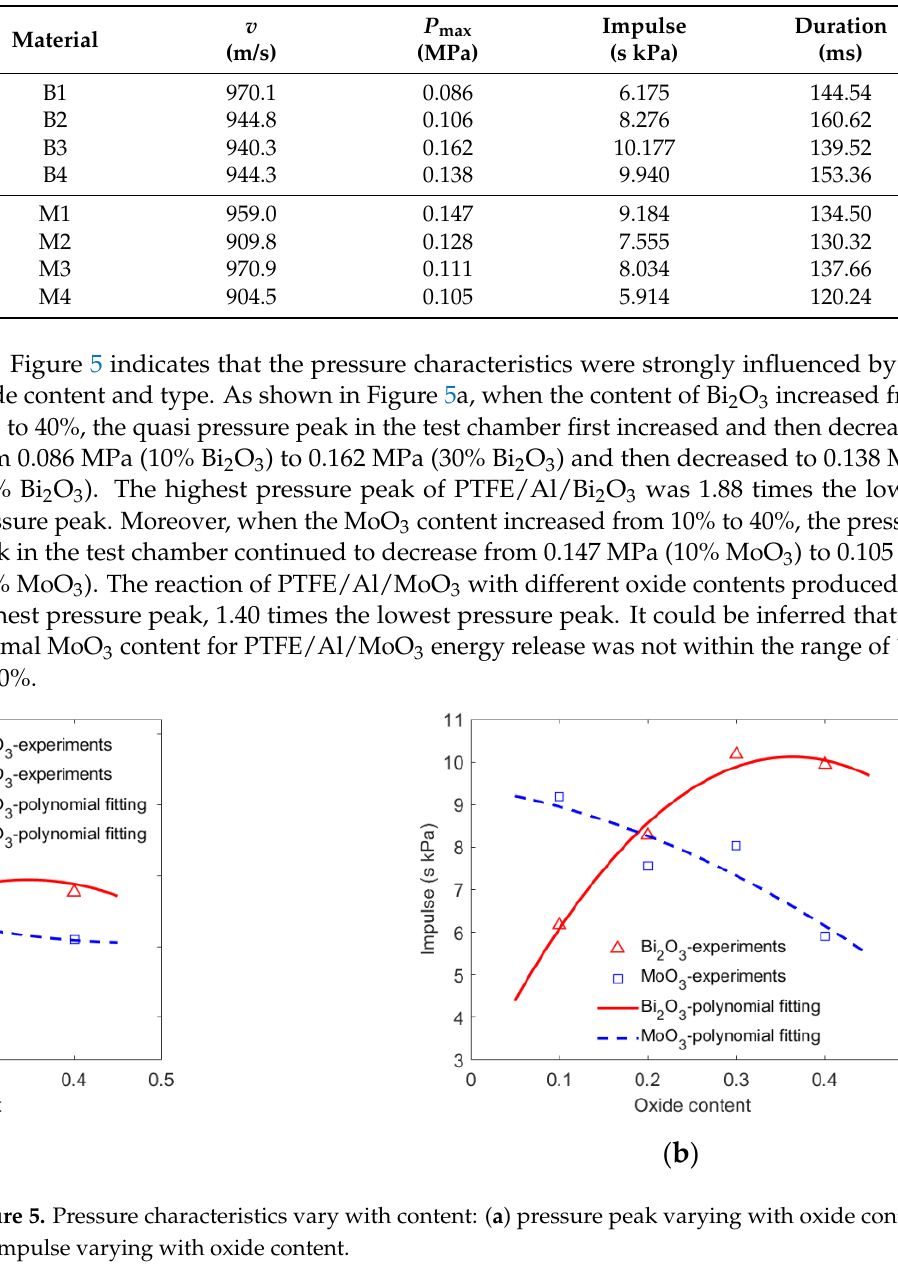
Table 3. The reaction pressure characteristics of PTFE/Al/oxide in test chamber.